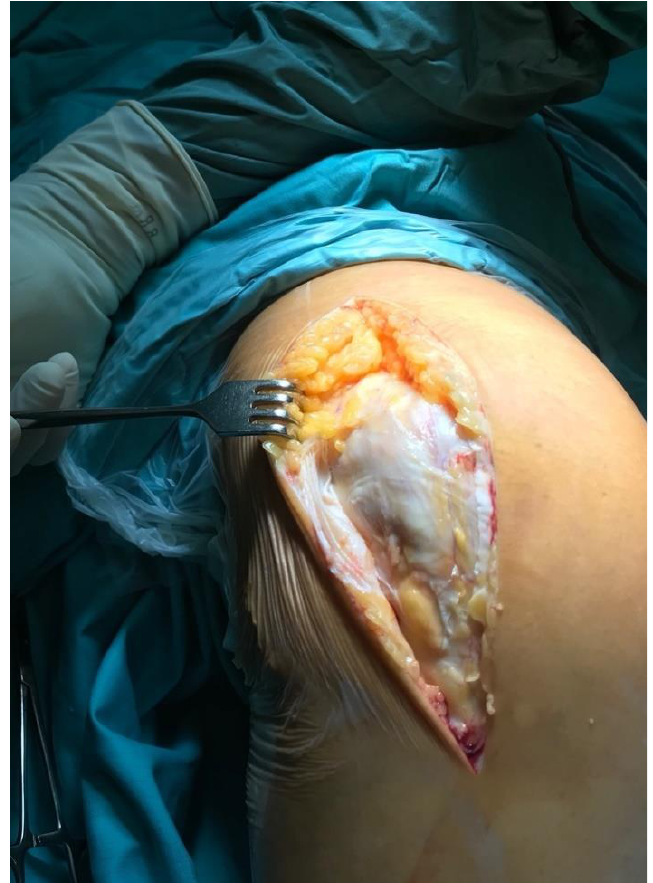
Figure 2. Skin incision.